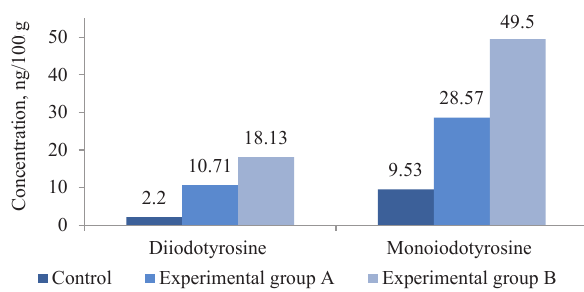
Figure 1 Iodotyrosine content in pig muscle tissue